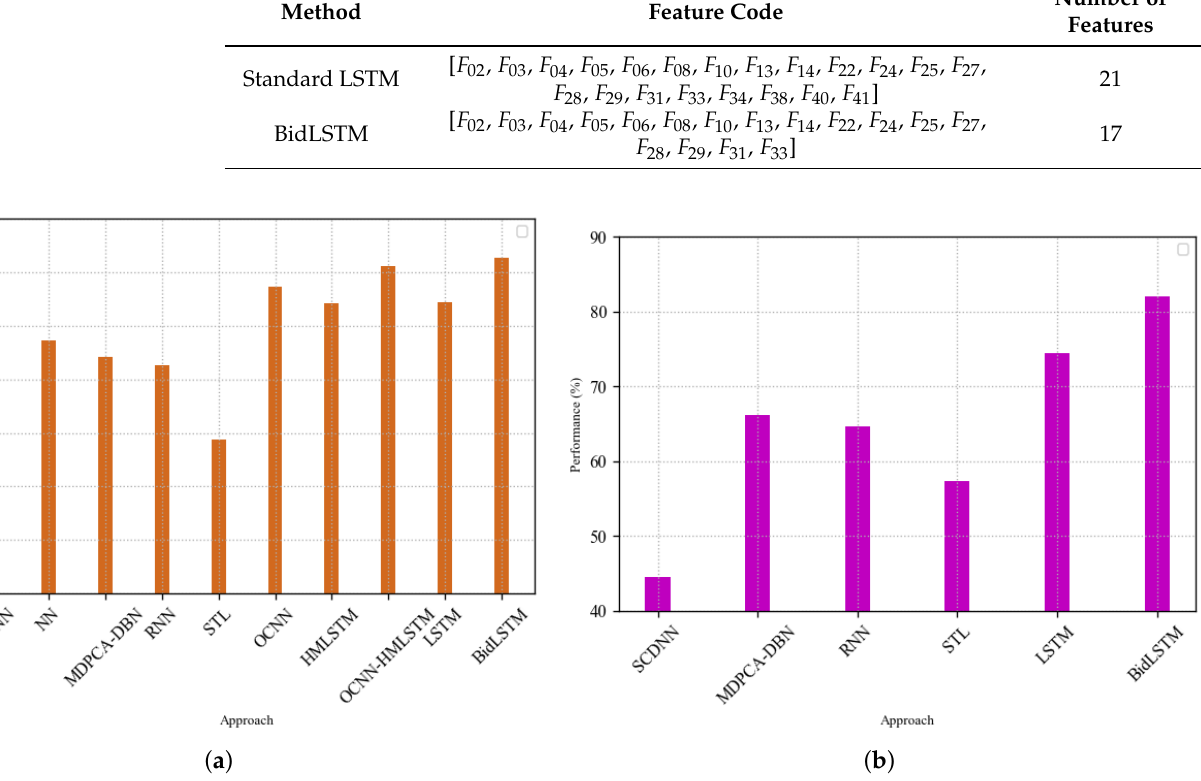
Figure 5. Comparison of results against existing methods on NSL-KDDTest + and NSL-KDDTest − 21 using all 41 features. ( a ) Performance results on NSL-KDDTest + ; ( b ) performance results on NSL- KDDTest − 21 .